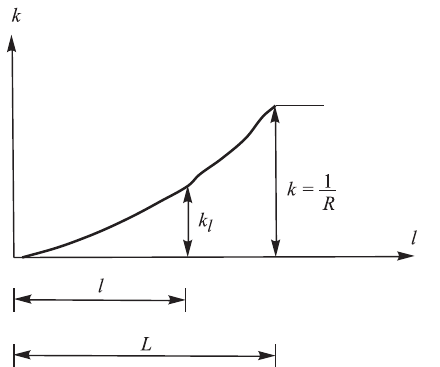
Fig. 1. Curvature change from 2 nd degrees (up the right